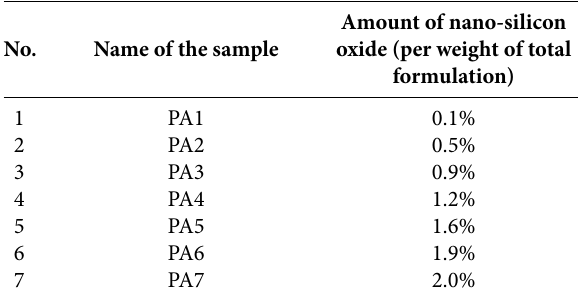
Table 2. Produced samples using a different amount of the nano- silica